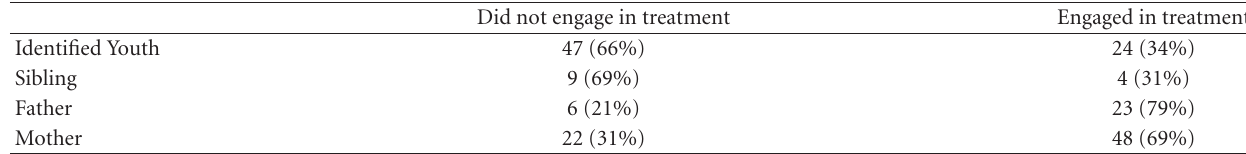
Table 2: Cross tabulation of engagement in treatment and type of family